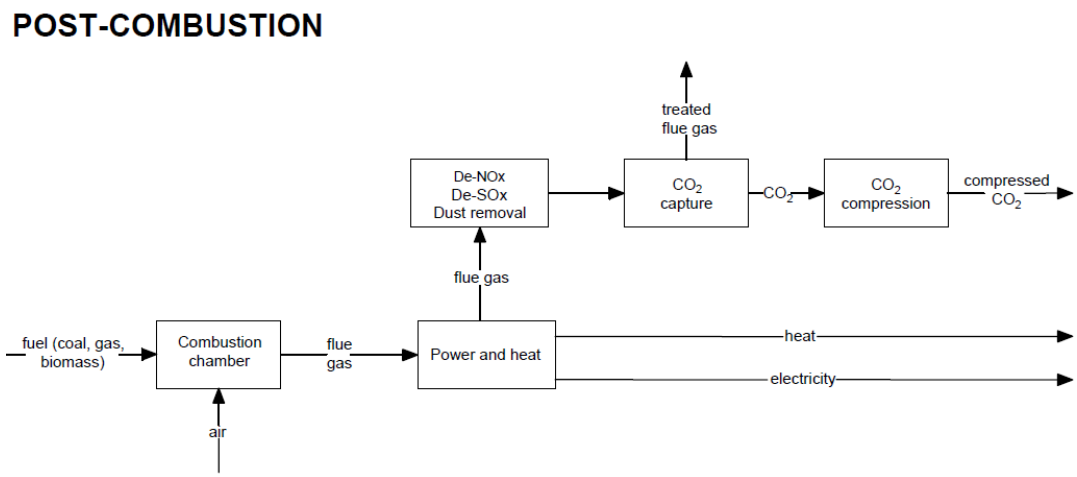
Figure 4. Block diagram of electricity generation and heat production through the use of the post- combustion CO 2 capture method.